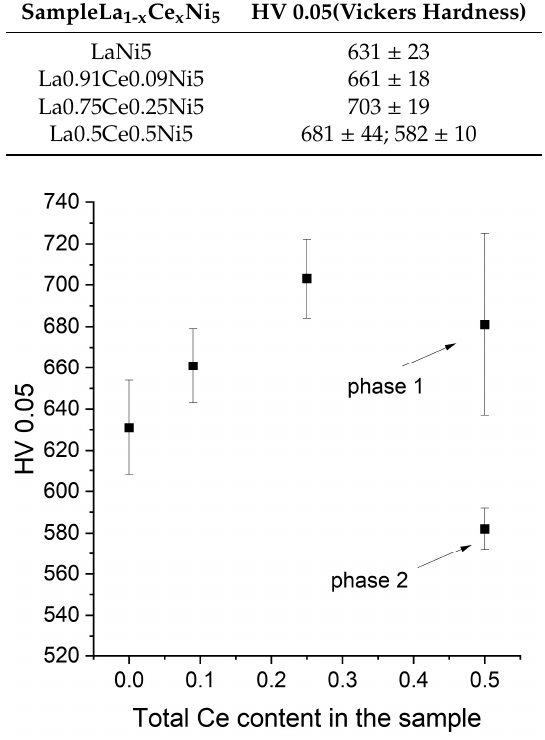
Table 4. Average of the measured microhardness values for the LaNi 5 , La 0.91 Ce 0.09 Ni 5 , La 0.75 Ce 0.25 Ni 5 and La 0.5 Ce 0.5 Ni 5 samples.